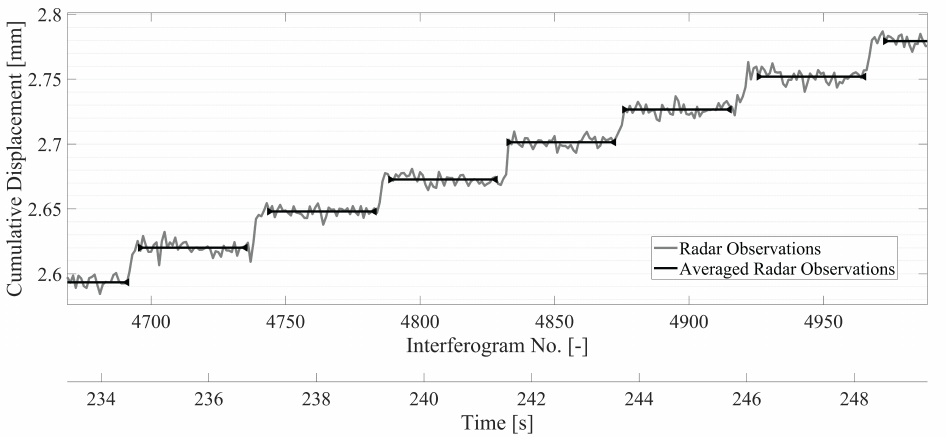
Figure 13. Excerpt of the cumulative displacements in millimeters for the corner cube mounted on the translation stage moving in steps of 25µm for the experiment carried out